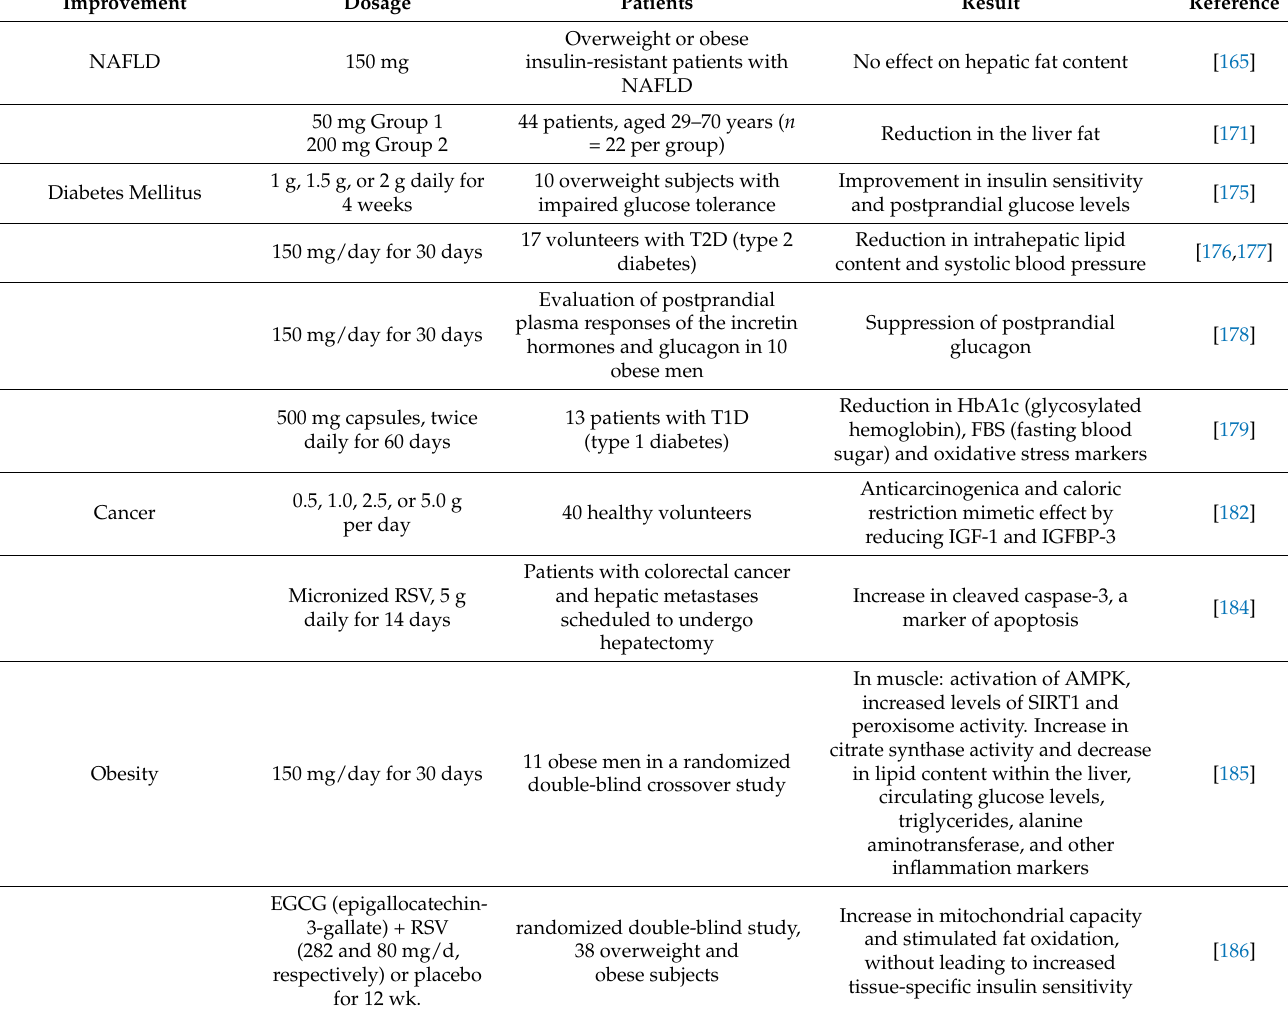
Table 2. Summary results of the clinical trials of Resveratrol in different